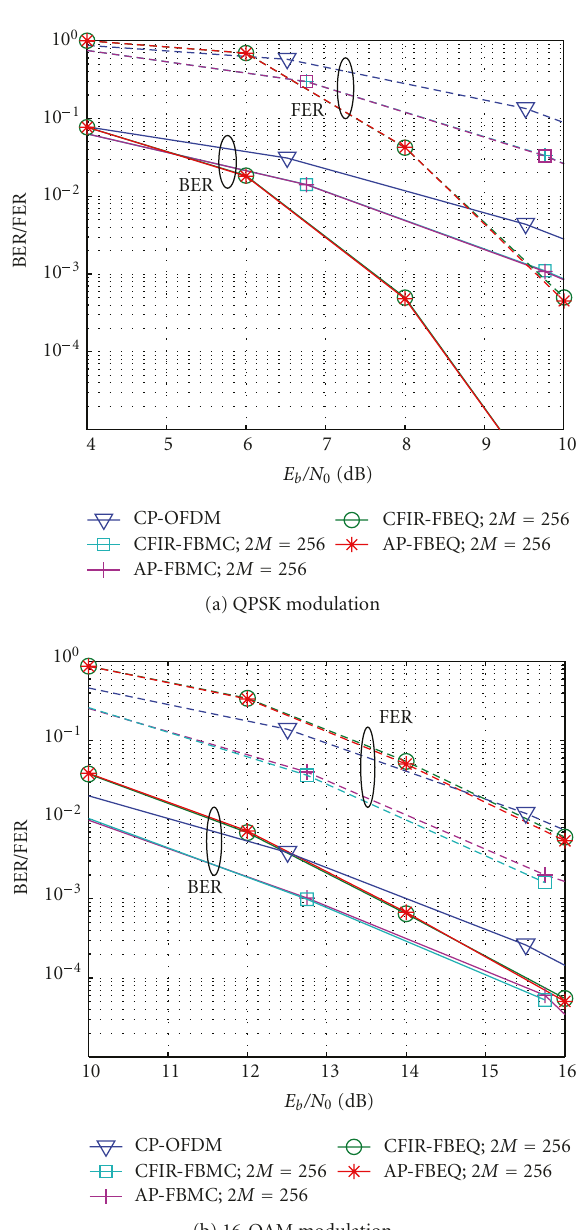
Figure 12: Coded BER and FER performance comparison between CP-OFDM, FBMC, and FB-FSE with practical system parameters and LDPC coding. Both 3-tap CFIR and AP Case 3 subband equal- izers are included in FBMC and FB-FSE